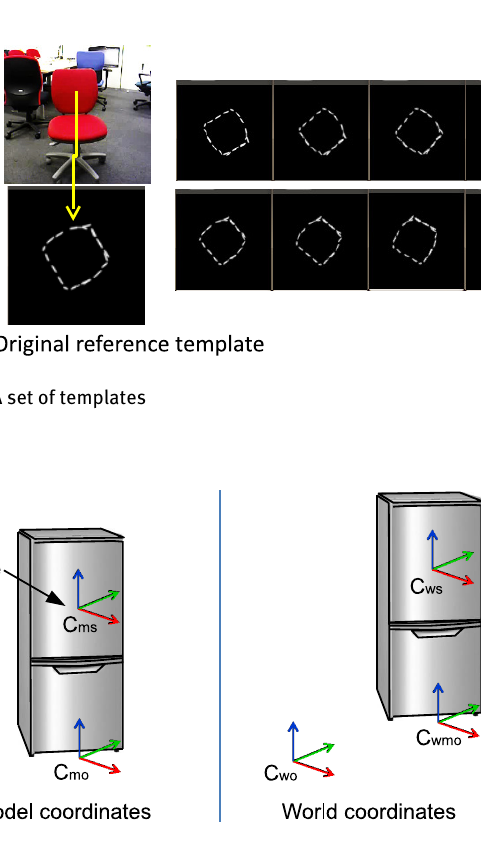
Figure 4: Relationship between model and world